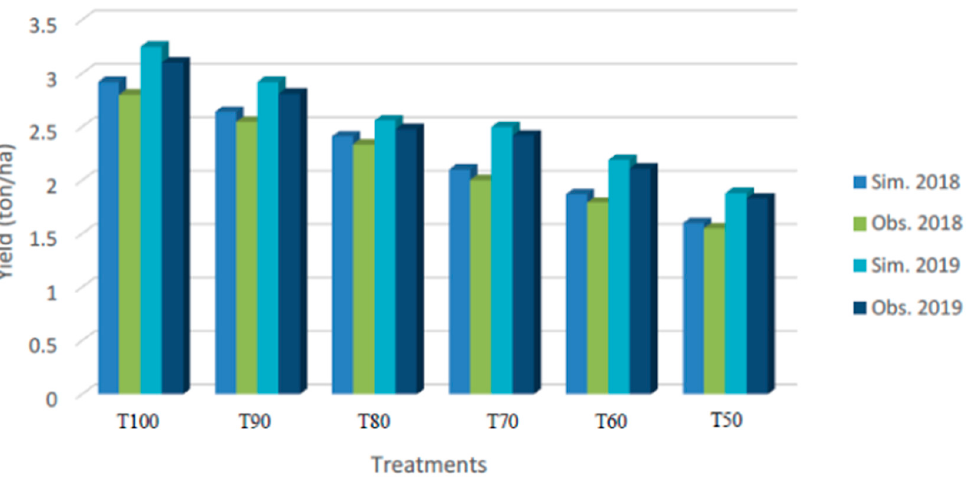
Figure 11. Comparison of the yield (t/ha) simulated by the AquaCrop model with values observed for the barley crop at different water stress levels .